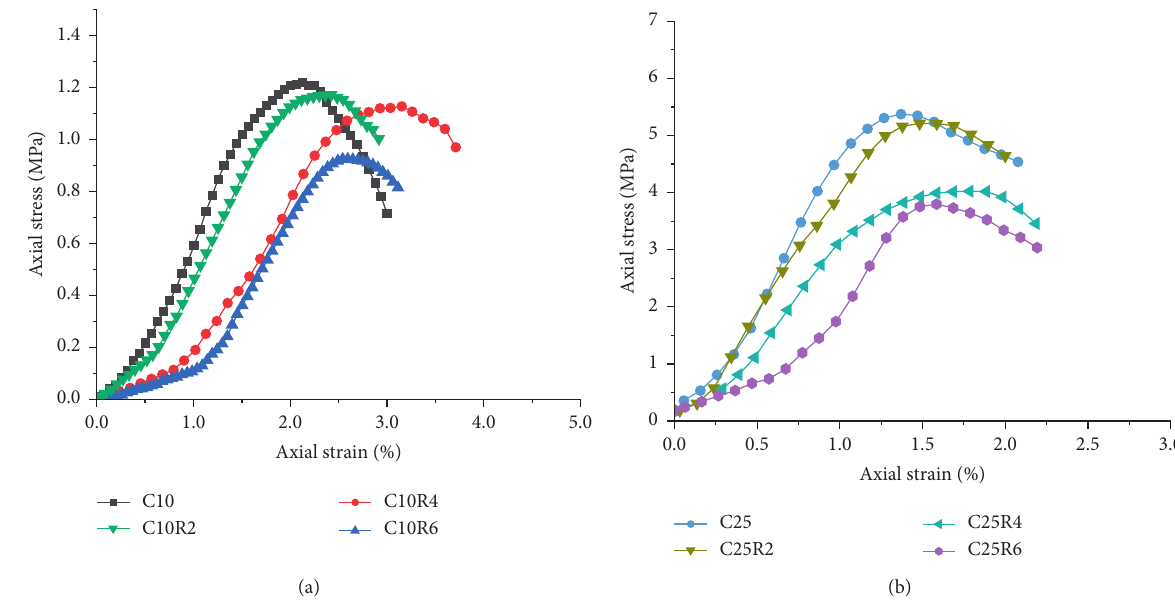
Figure 3: Typical stress-strain curves of (a) 10% and (b) 25% cement content cemented tailings samples.